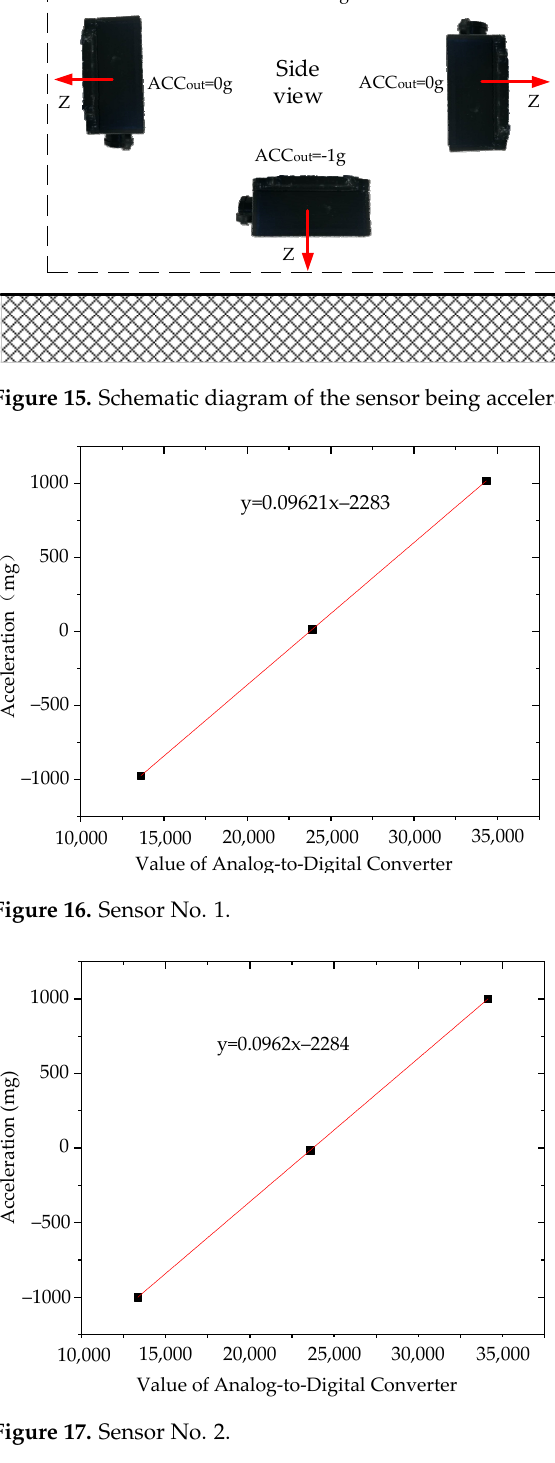
Figure 17. Sensor No. 2.